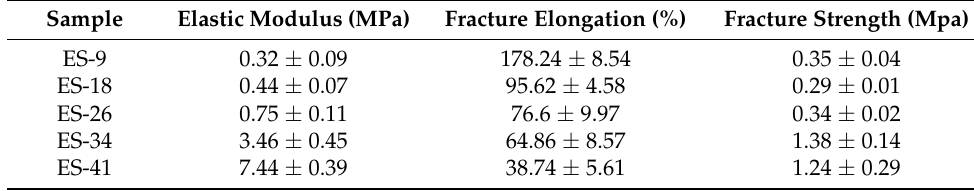
Table 3. Tensile properties of modified silicone tie-coatings.